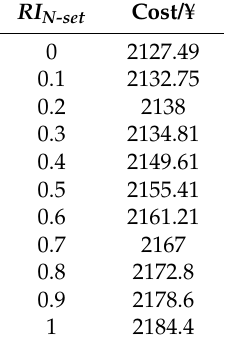
Table 2. Electricity cost under different robust indexes of the air-conditioning system.